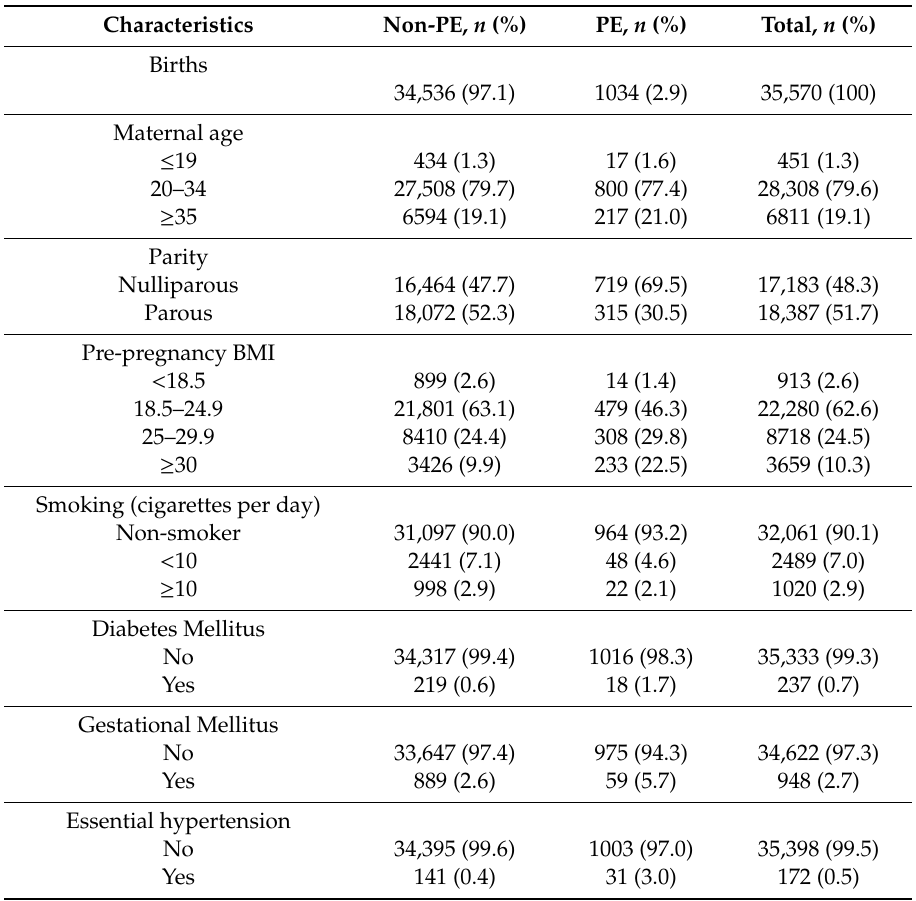
Table 1. The characteristics of the participants in Scania, Sweden over the 2000–2009